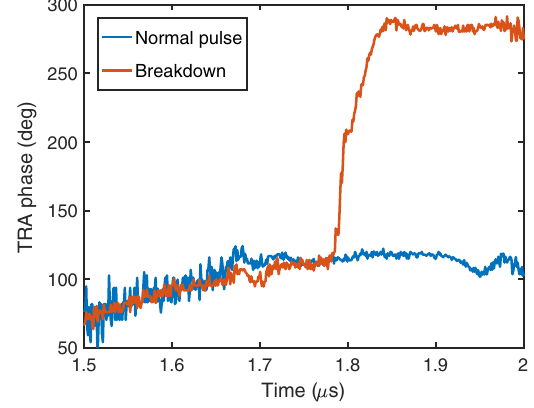
FIG. 10. Phase variation of the transmitted power signal during a breakdown with beam (red) compared to a normal rf pulse without breakdown (blue). The phase variation preceding the breakdown results from the rf pulse compression used for the rf pulse